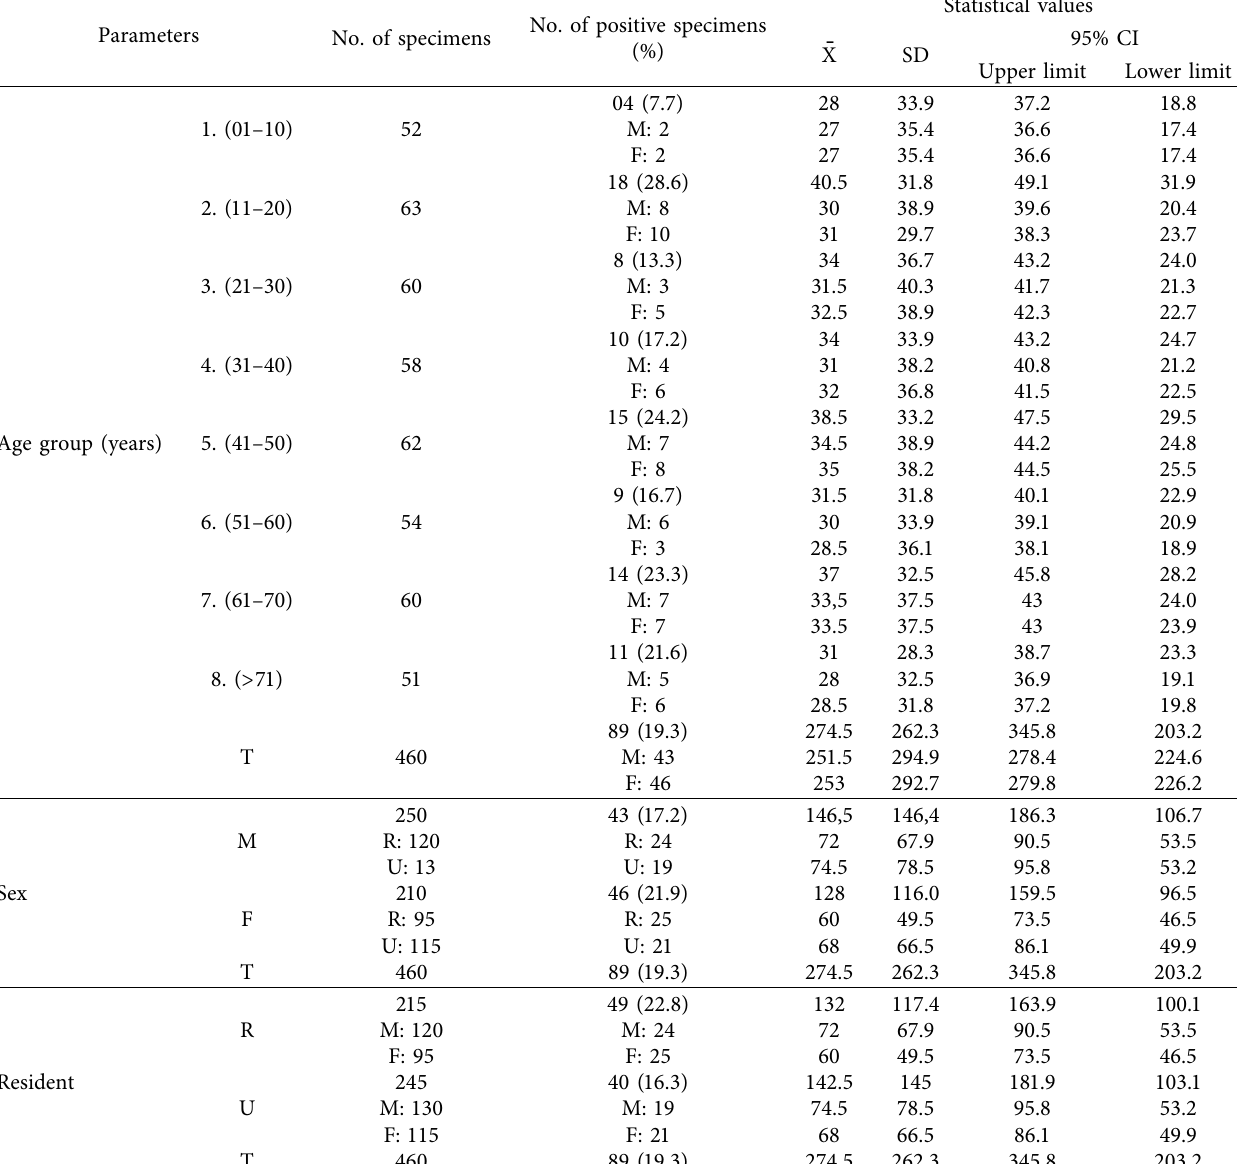
Table 2: Serological data based on socio-demographic and socio-economic parameters used for prevalence of H. pylori in Dhamar population. Parameters No. of